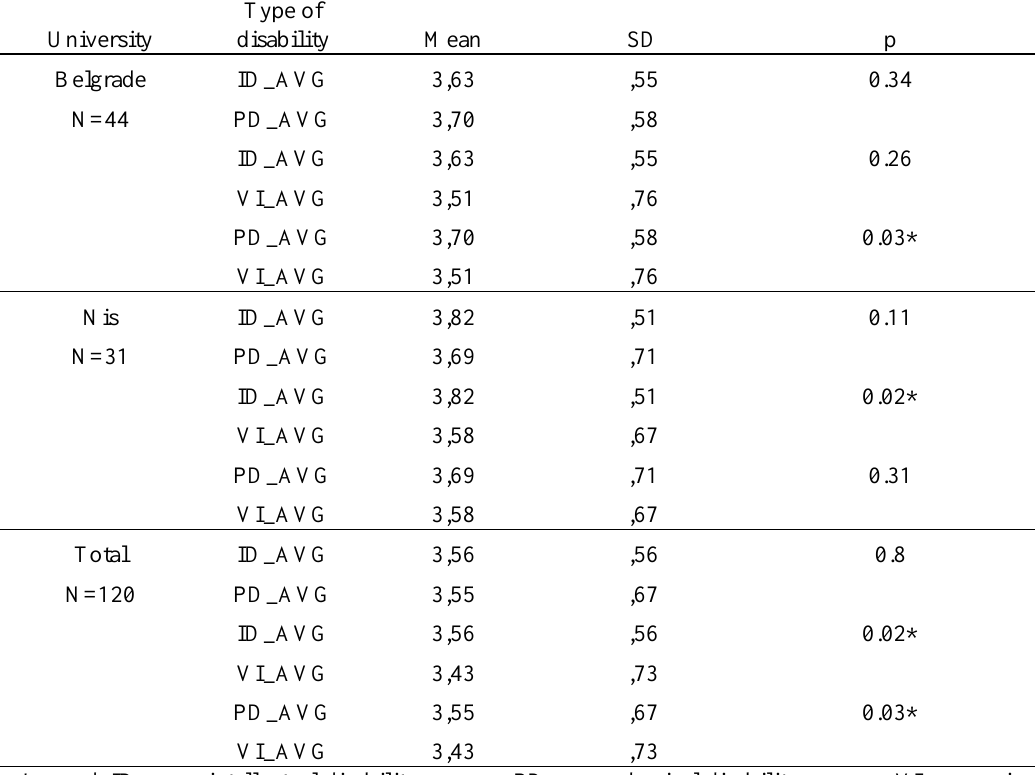
TABLE 5 Results of t-test for paired samples